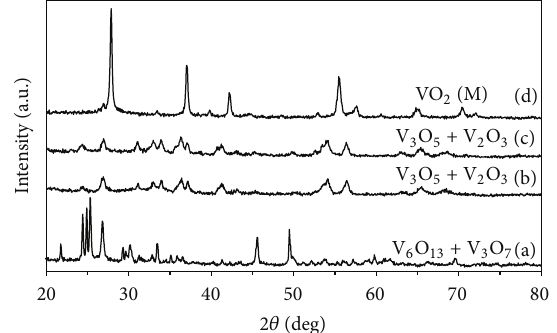
Figure 9: XRD patterns of vanadium oxide powders prepared by calcination of the 300 W microwave heated samples at 500 ∘ C for 1h withdifferentmolarratiosofNH 4 VO 3 andoxalicacid:(a)Nonoxalic acid, (b) 2: 2.6, (c) 2: 2.7, and (d) 2: 2.8.